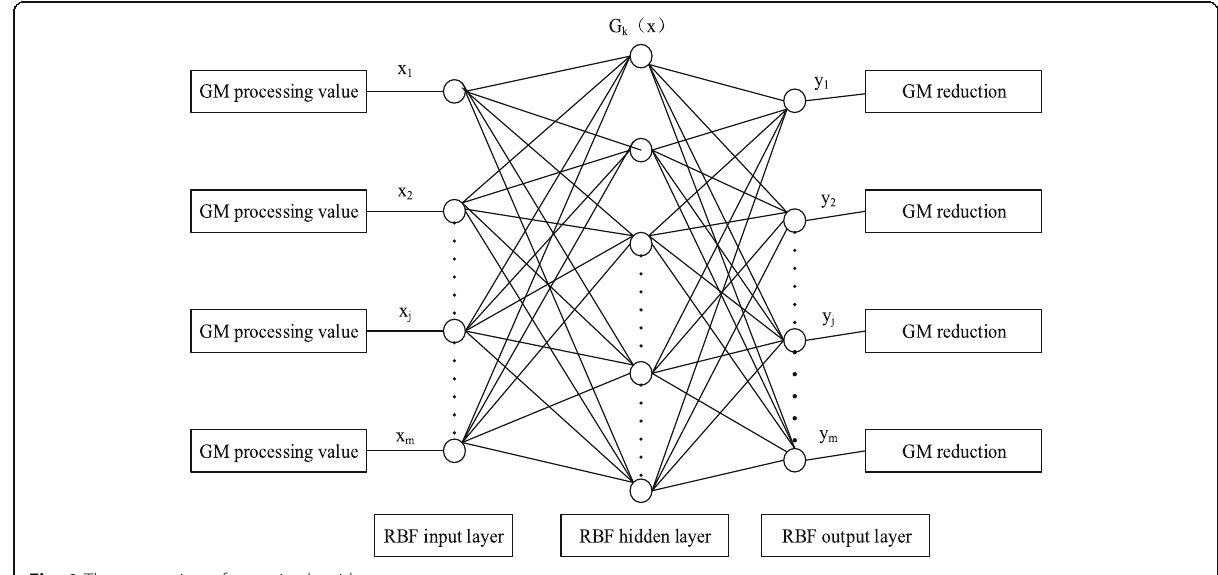
Fig. 1 The processing of genetic